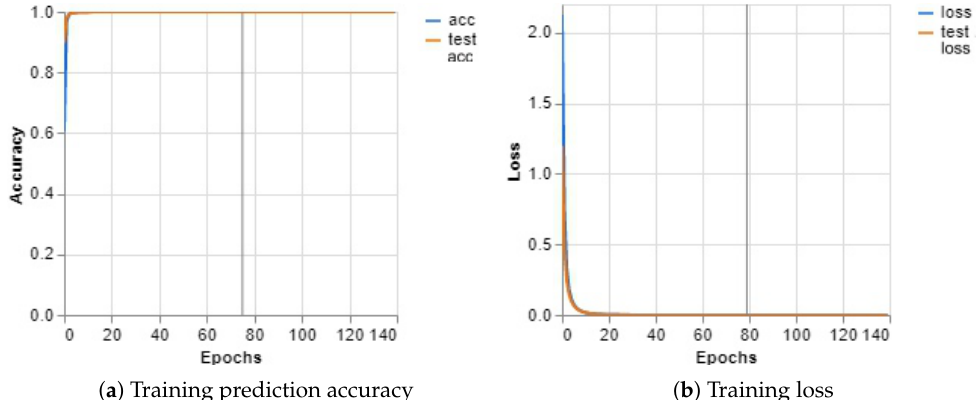
Figure 6. Training prediction accuracy and loss of ThermalAttackNet on 25 most commonly used passwords in 2018